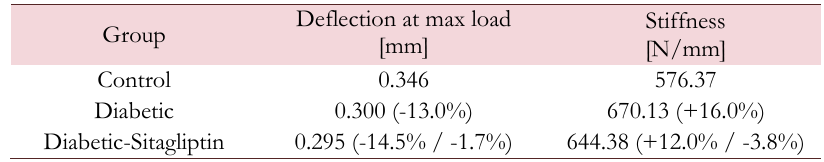
Table 3: The deflection at the maximum load and the stiffness of all